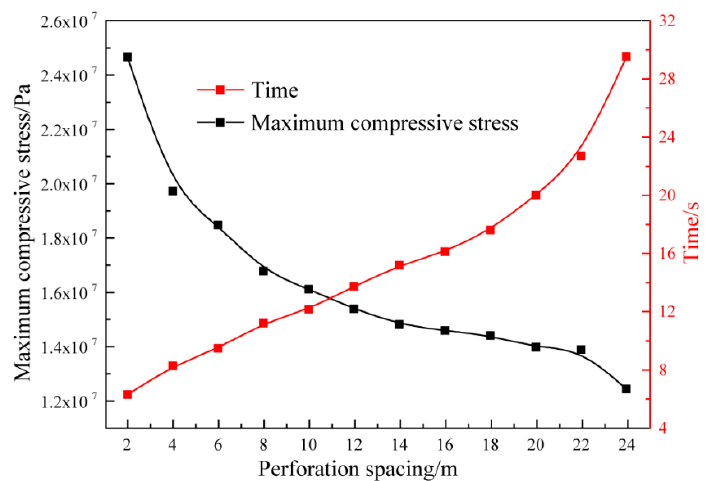
Figure 5. Variation curve of maximum compressive stress at the center of two perforations with perforation spacing. The black and red lines indicate the value of maximum compressive stress and the time to reach the maximum compressive stress, respectively. With the increase in perforation spacing, the maximum compressive stress decreases and the time